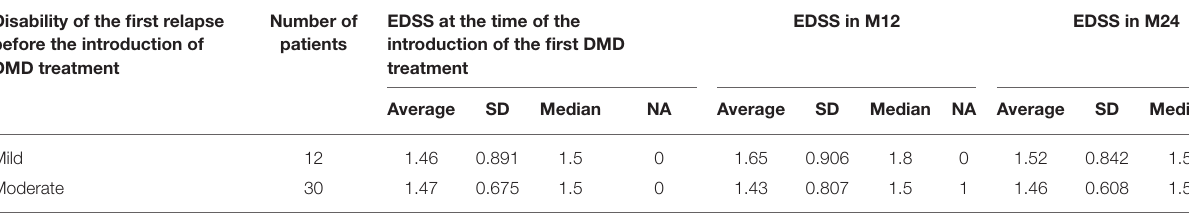
TABLE 3 | Relationship between the first relapse and disability (Group A).